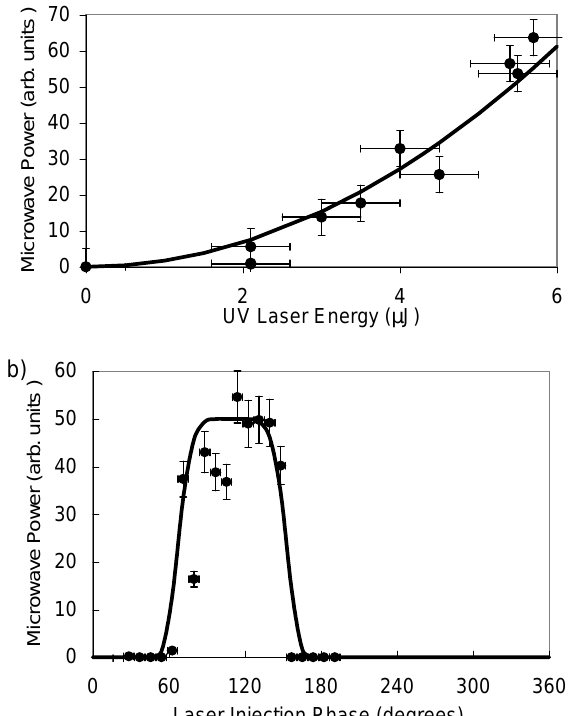
FIG. 17. Coherent synchrotron radiation measurements: (a) ra- diation intensity as a function of laser energy with a quadratic fit, and (b) radiation intensity as a function of rf phase relative to laser injection. The fit in (b) is the equation resulting in the fit of Fig. 13 squared (only the total amplitude was varied, not the width).